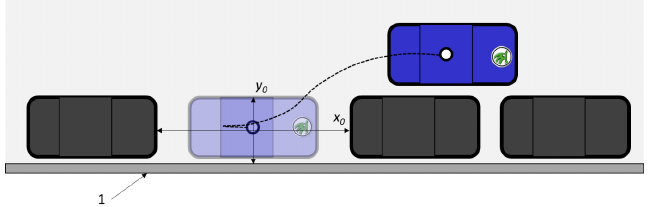
Figure 9. Schematic drawing of parallel parking maneuver: 1—curb, x 0 —slot length, y 0 —slot depth.